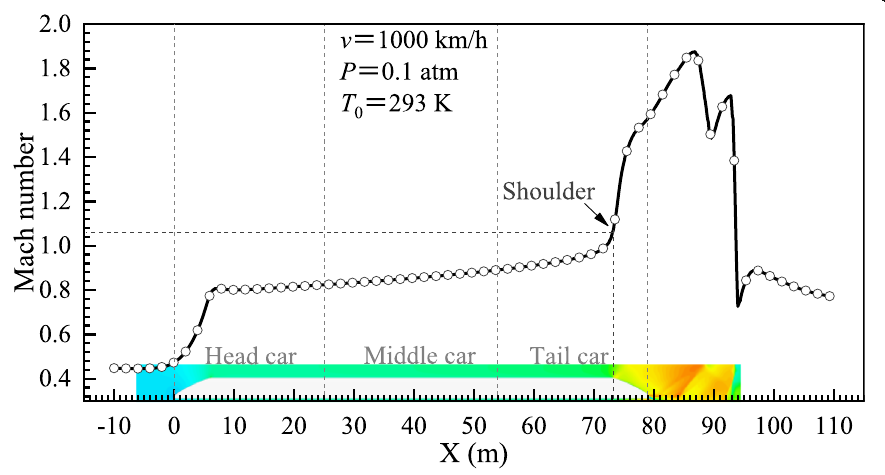
Fig. 11 Mach number along the top of tube wall: x -coordinate ranges from − 10 m to 110